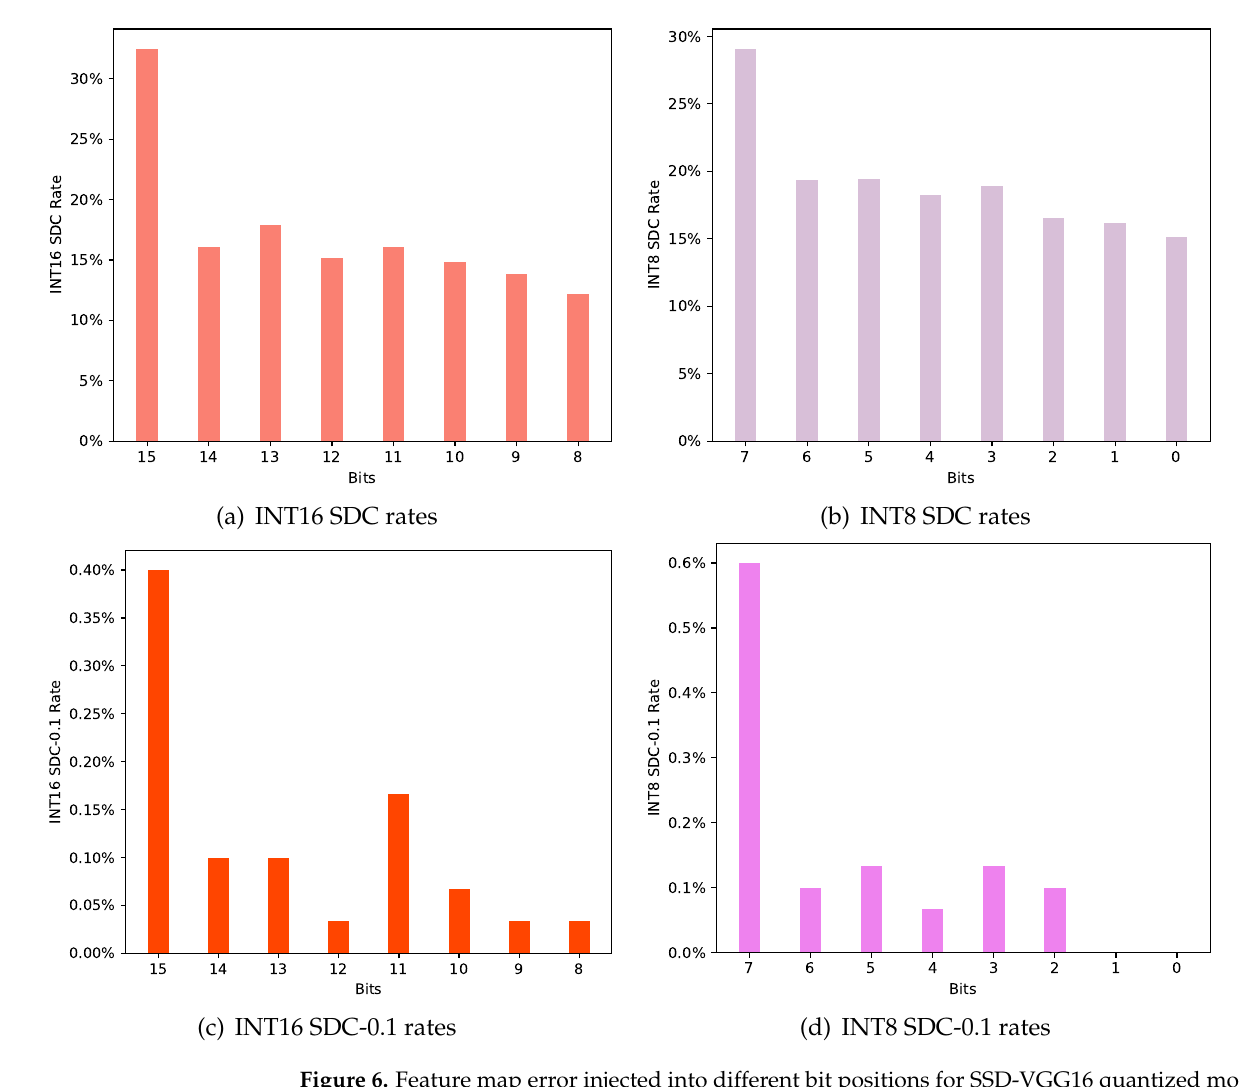
Figure 6. Feature map error injected into different bit positions for SSD-VGG16 quantized models. ( a ) shows the SDC rate for errors injected into the higher 8 bits in the INT16 model; ( b ) shows the SDC rate for errors injected into different bits in the INT8 model; ( c ) shows the SDC-0.1 rate for errors injected into the higher 8 bits in the INT16 model; ( d ) shows the SDC-0.1 rate for errors injected into different bits in the INT8 model.